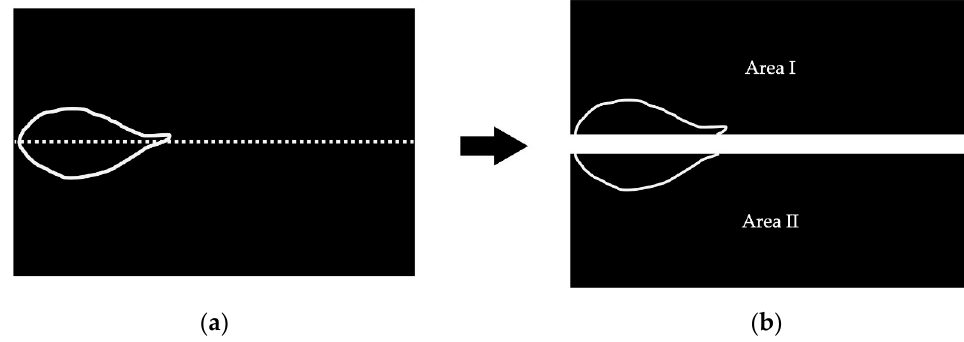
Figure 8. ( a ) Full area of image and ( b ) area 1 and area 2 for leaf image.